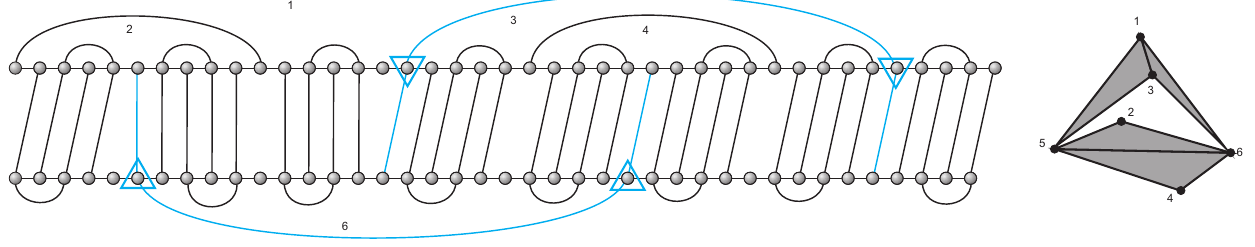
Figure 12. LHS: A τ -structure having an incomplete component (colored in blue and with its loops labeled by numbers and its 2-simplices labeled by triangles). RHS: The complex induced by the incomplete component indicates that it contains two